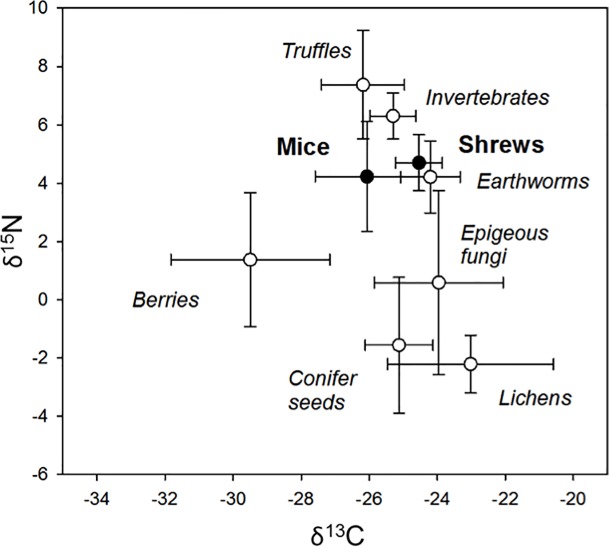
Stable carbon and nitrogen values for Keen’s mice, dusky shrews and the potential foods.Values of δ13C and δ15N (average ± 95% confidence intervals) for blood and muscle tissues of Keen’s mice and dusky shrews captured on Prince of Wales Island, Alaska 2010–2012. Potential diet items were corrected for consumer-diet discrimination by using a trophic enrichment factor of 1.3‰ for δ13C and 2.5‰ for δ15N in relation to shrew diets.